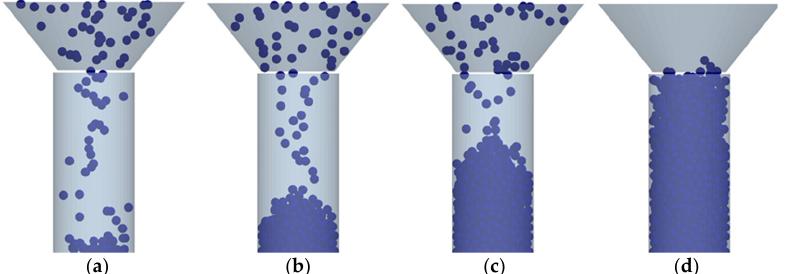
Figure 2. The course of cylinder filling modelling with bulk material to determine the density of its particles: ( a – d ) the next steps in the process.